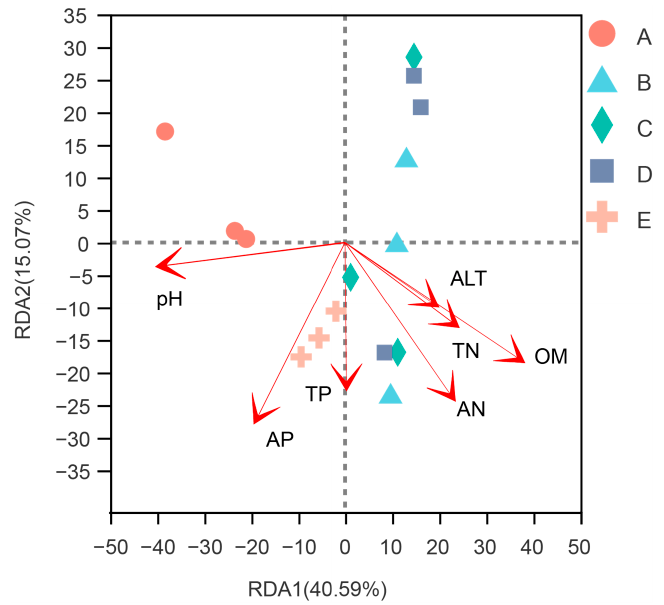
Figure 4. Redundancy analysis between soil chemical properties, altitude, and bacterial commu- nity. A, C. kerrii forest; B, the lower range limit of C. pingbianense forest; C, the range center of C. pingbianense forest; D, the upper range limit of C. pingbianense forest; E, L. glaber forest. OM, organic matter content; AN, available N content; AP, available P content; TN, total N content; TP, total P content; ALT, altitude.